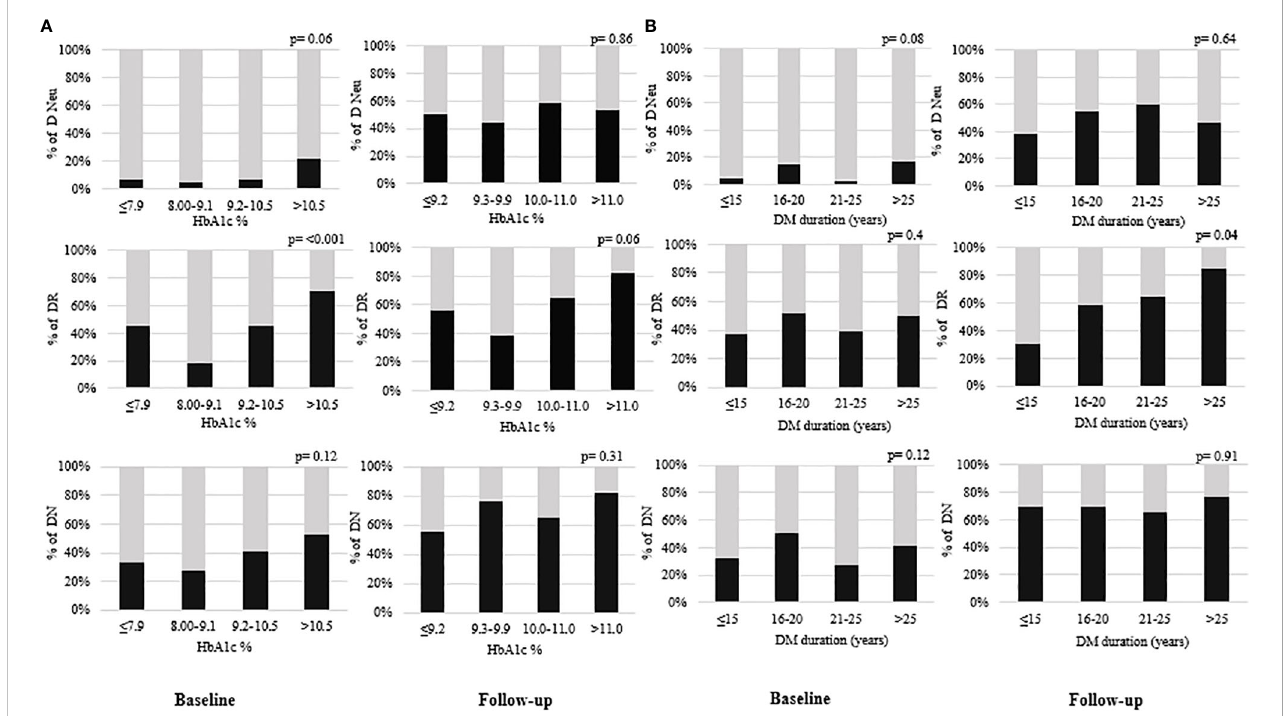
FIGURE 3 (A) shows the percentage distribution of microvascular complications in quartiles of HbA1c and (B) shows the percentage distribution of microvascular complications in different groups of DM duration (years) at baseline (N=162) and follow-up (N=70). Dark color shows the “ presence ” and light color shows “ absence ” of corresponding complication. DM duration (diabetes mellitus duration), DN (diabetic nephropathy), DR (diabetic retinopathy), D Neu (diabetic neuropathy). P value <0.05 is statistically signi fi